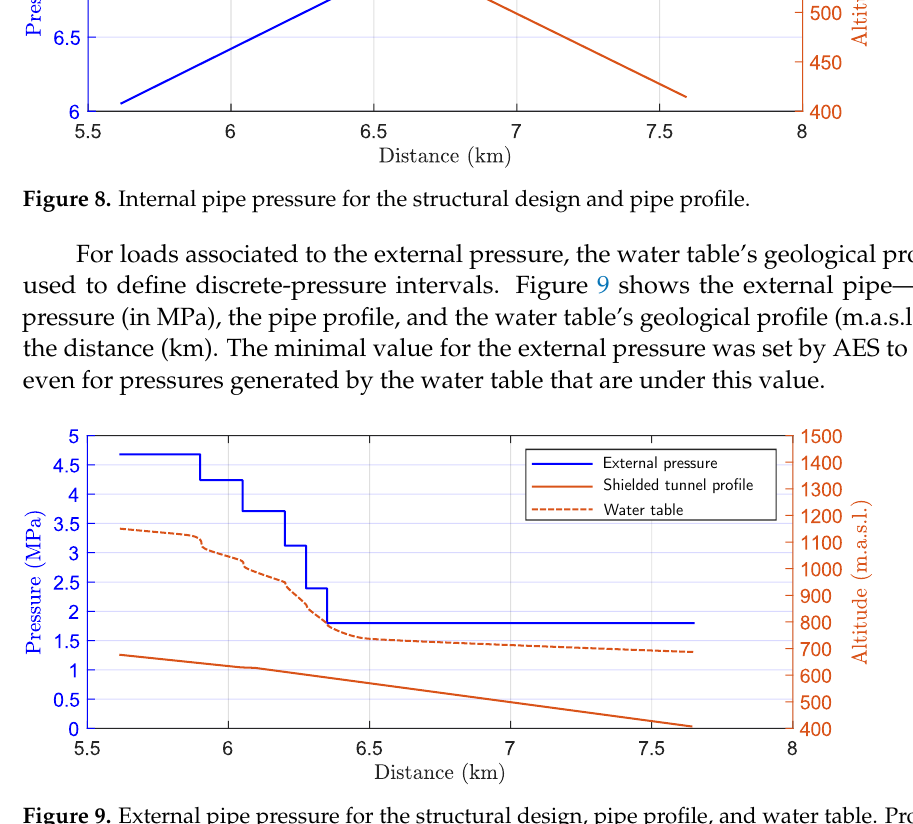
Figure 9. External pipe pressure for the structural design, pipe profile, and water table. Provided by the